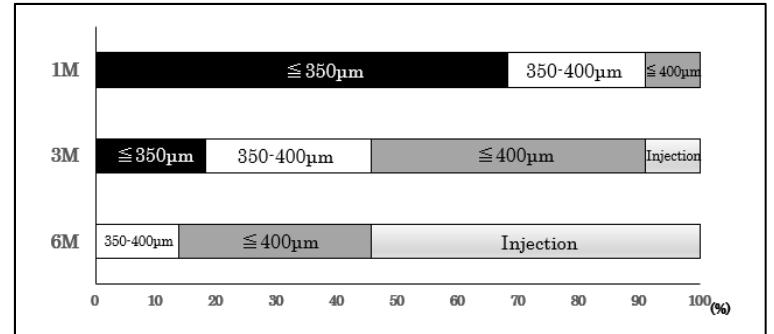
Figure 2. Eyes after the loading injection.